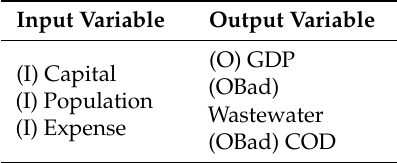
Table 1. Input and output variables. GDP: Gross domestic production, COD: Chemical oxygen demand.